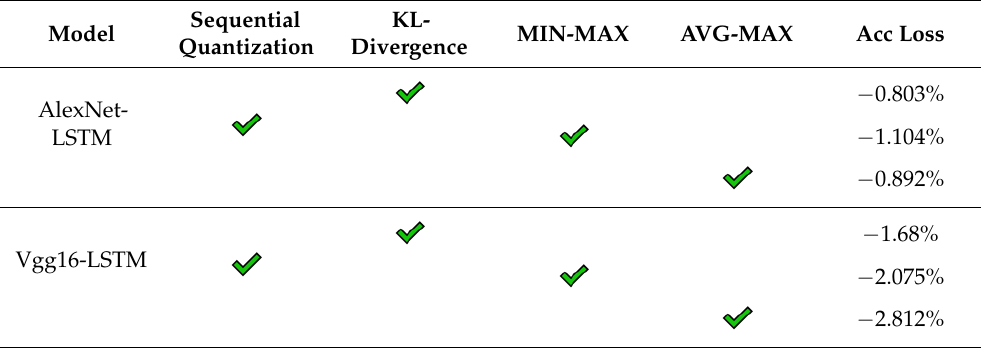
Table 8. Experiment on activation quantization clipping.